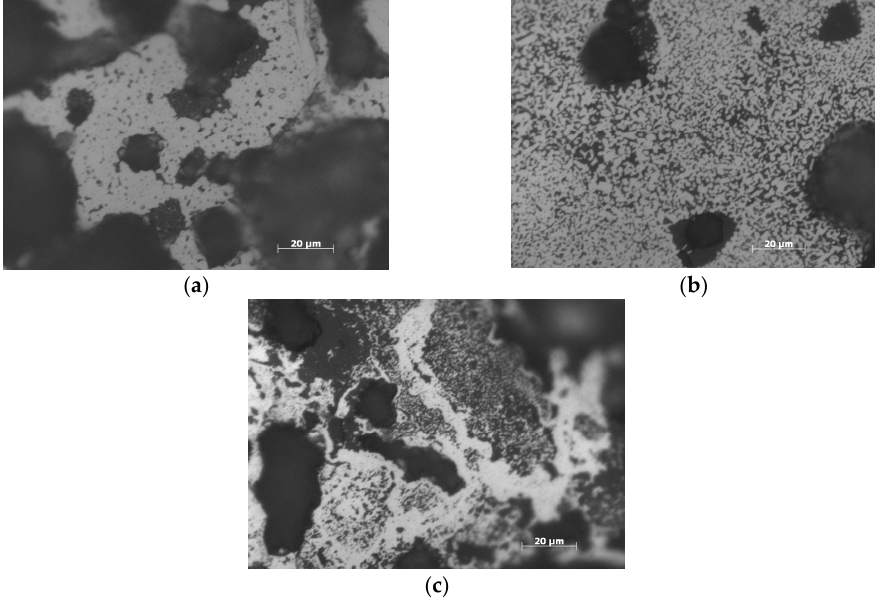
Figure 2. Microstructure of SHS composites based on titanium diboride with additions of MgAl 2 O 4 : ( a ) 90% (Ti + 2B) + 10% MgAl 2 O 4 ; ( b ) 75% (Ti + 2B) + 25% MgAl 2 O 4 ; ( c ) 60% (Ti + 2B) + 40% MgAl 2 O 4 . When 45% MgAl 2 O 4 is added to the composite, the mixture does not burn in this case, because MgAl 2 O 4 is inert.